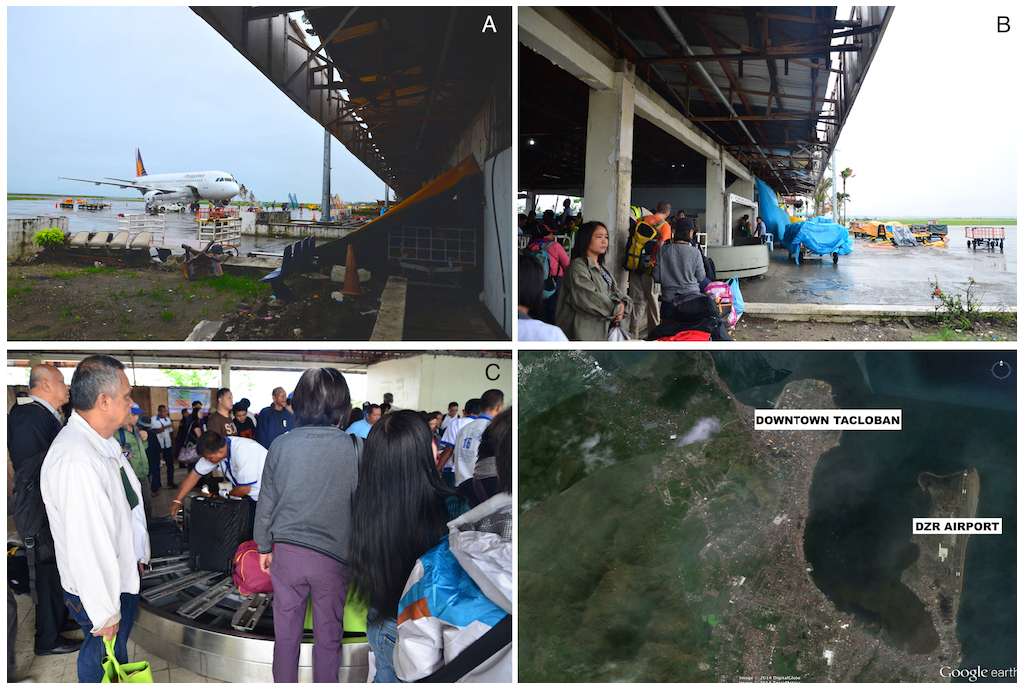
Figure 9. (a, b) Damage to the walls and roof of a gate to the side of the runway. (c) Passengers arriving and baggage claim belt out of service due to damage.